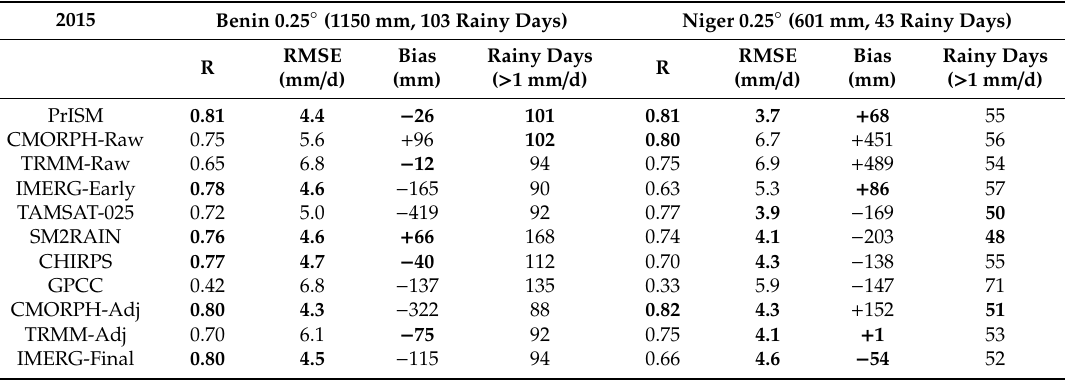
Figure 3. Example of comparison between in situ precipitation measurements (Benin 0.25 ◦ site, 2015, in grey) and the ten precipitation products (Precipitation Inferred from Soil Moisture (PrISM), SM2RAIN, CMORPH (Raw and Adj), TRMM (Raw and Adj), IMERG (Early and Final), Climate Hazards group Infrared Precipitation with Stations (CHIRPS)-025 and Tropical Applications of Meteorology using SATellite and ground-based operations (AMSAT)-025). Bars show daily rainfall amounts (left axis), curves show cumulative rainfall (right axis). Statistical scores are reported in Table 3. Table 3. Statistical scores (R, RMSE, annual bias and nb of rainy days) between in situ precipitations measurements (Benin and Niger, 2015) and the eleven precipitation products. Bold values indicate the best performances. There are 103 rainy days in Benin and 43 rainy days in Niger in